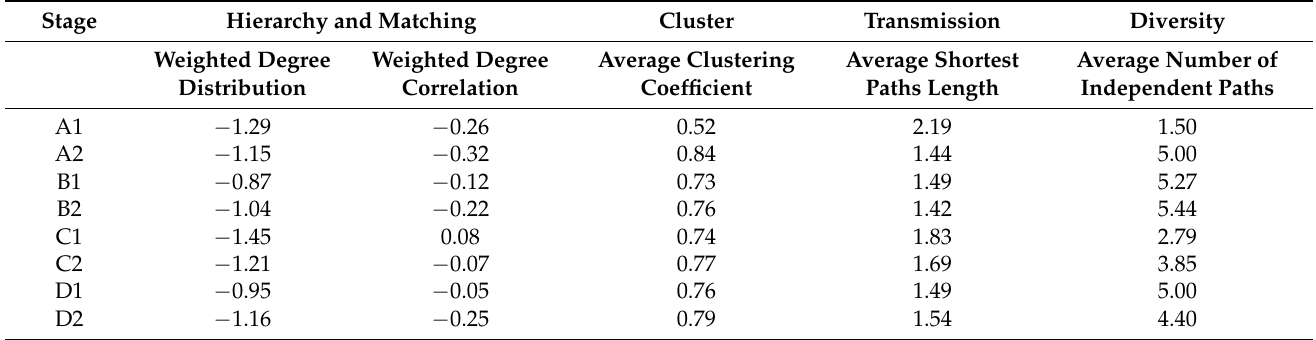
Table 2. Comparison of the measurement results of the population mobility network resilience